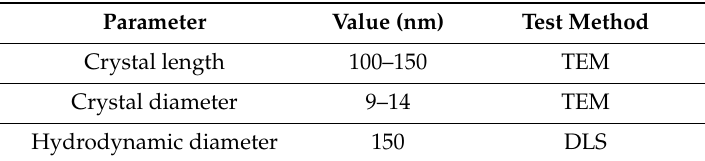
Figure 3. Particle size distribution. Table 1. Dimensions of CNC.